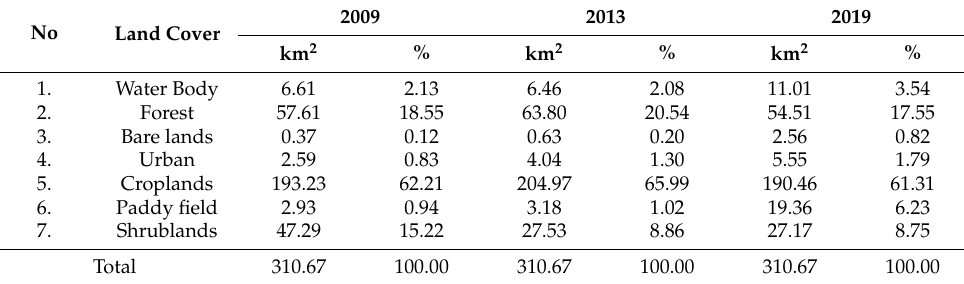
Table 2. Land cover change data from 2009 to